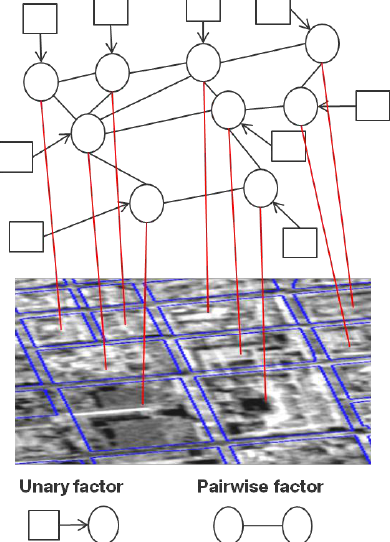
Figure 4. Construction of the CRFs model. Squares represent the observed variables and the circles represent the unknown UST class of the blocks. A pairwise factor is created between two blocks if they are considered to be neighbours by a distance